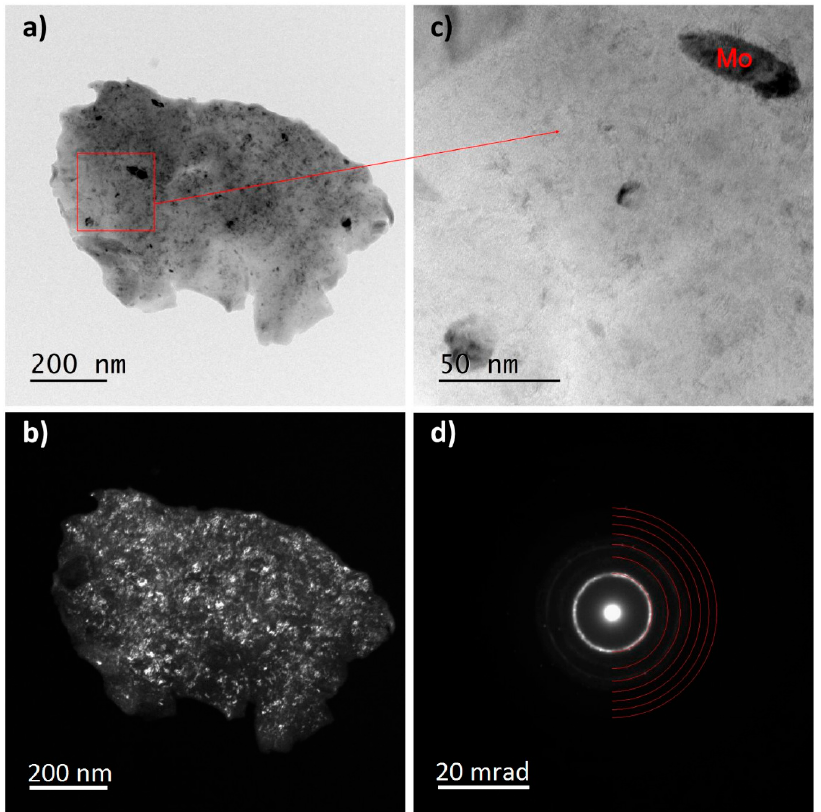
Figure 10. TEM analysis of the TTM3S powder that was milled for 100 h; ( a ) TEM bright field image; ( b ) TEM dark field images; ( c ) HR ‐ TEM image; and ( d ) SAED pattern of the β phase.